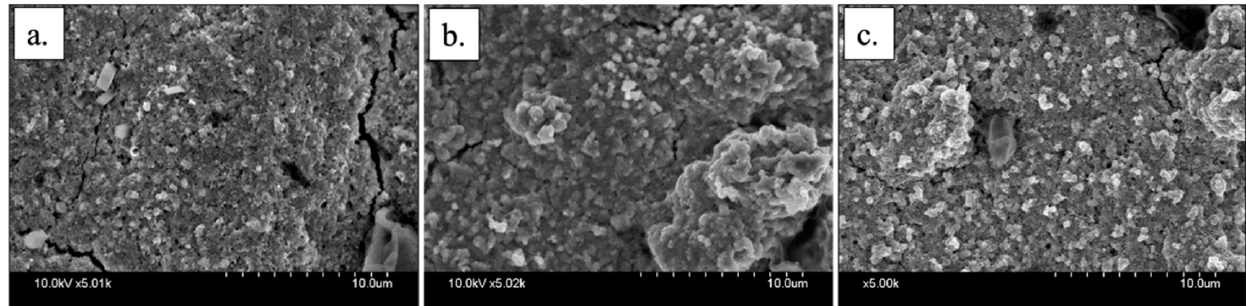
Figure 14. SEM morphologies (magnification 5k × ) of 2W sintered thin films with scanning speed 150mm/s, and frequencies 90k Hz ( a ), 105k Hz ( b ), and 120k Hz ( c ).